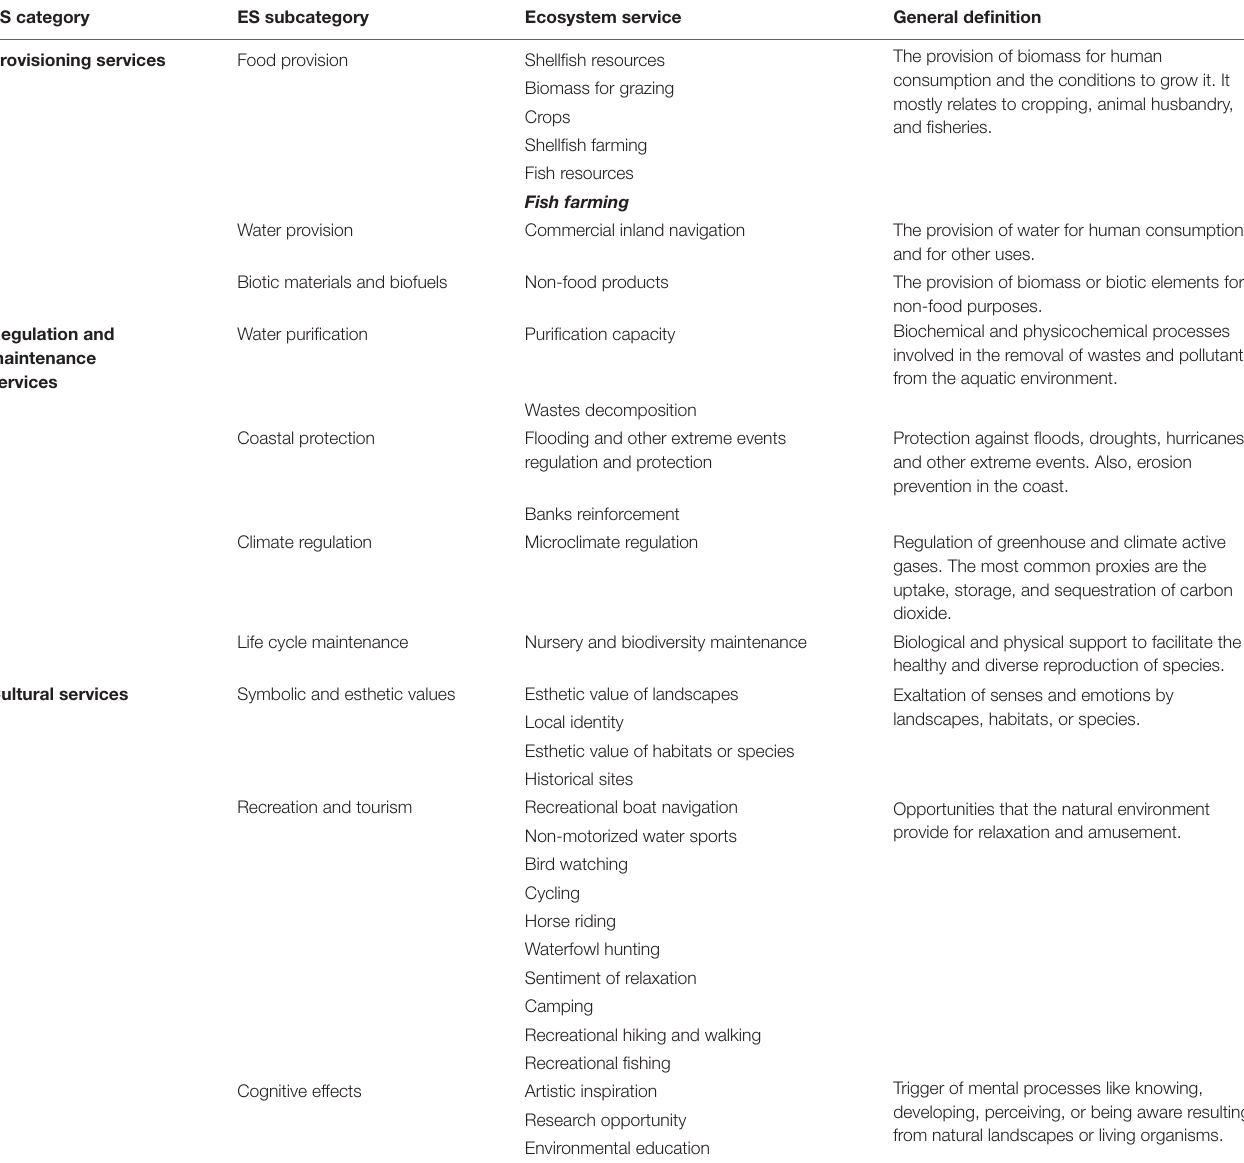
TABLE 2 | Modified from Sy et al.